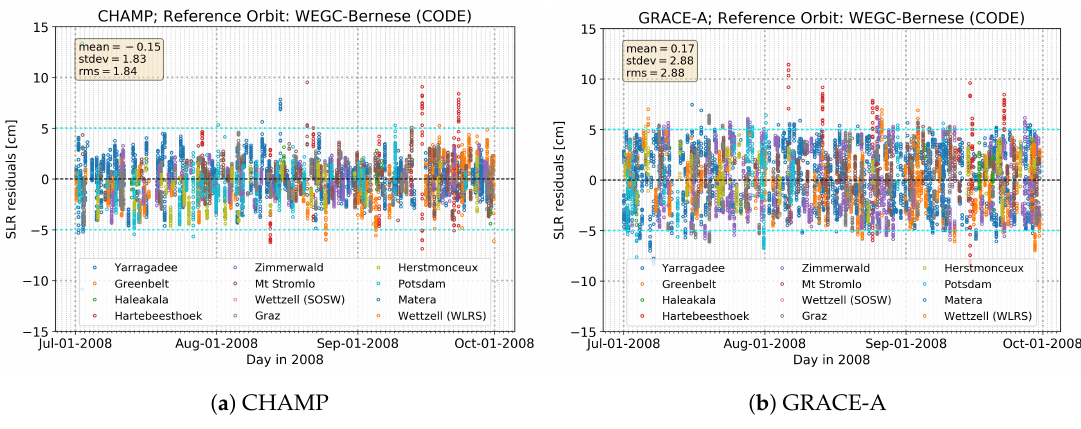
Figure 5. SLR residuals of ( a ) CHAMP and ( b ) GRACE-A orbits for July to September 2008, calculated with Bernese using GNSS input from CODE for a set of 12 high-quality SLR stations (legends at bottom). Average mean, standard deviation, and 3D-root-mean-square (RMS) estimates over the period are noted in the upper-left legend (units cm). For outlier rejection a 20 cm threshold and a station’s elevation mask of 10 degrees was